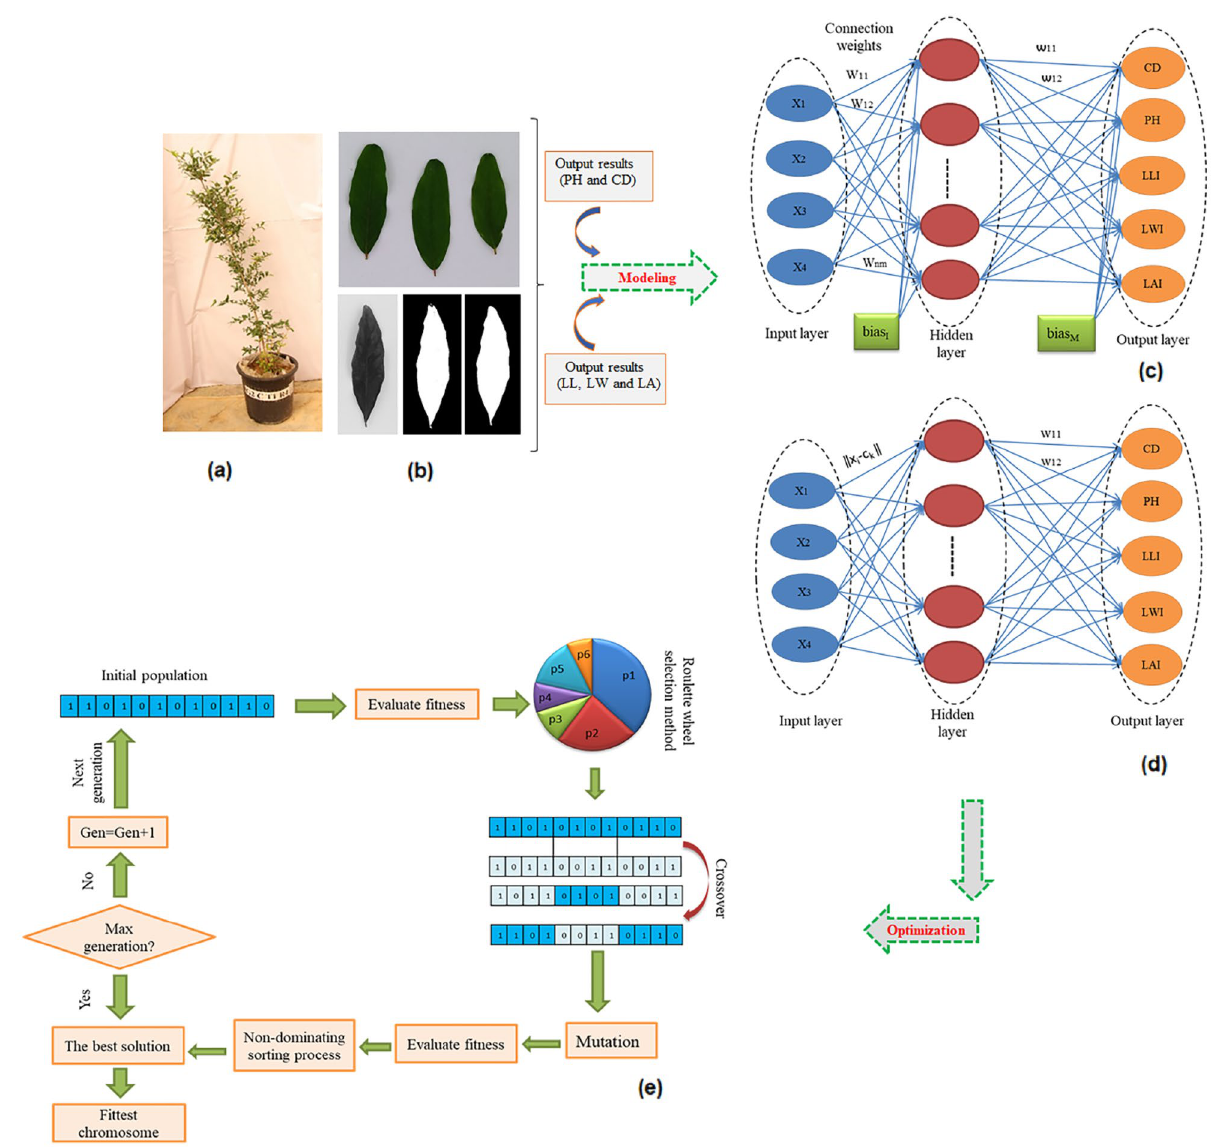
Figure 1. Schematic diagram of the procedure used in this study ( a , b ) image processing and morphological measurements, ( c , d ) modeling morphological traits based on four input variables including pomegranate cultivars, GABA concentrations, stress treatments and days of treatment using multilayer perceptron (MLP) and radial basis functions (RBF), respectively, and ( e ) the step-by-step optimization process of morphological traits via non-dominated sorting genetic algorithm-II